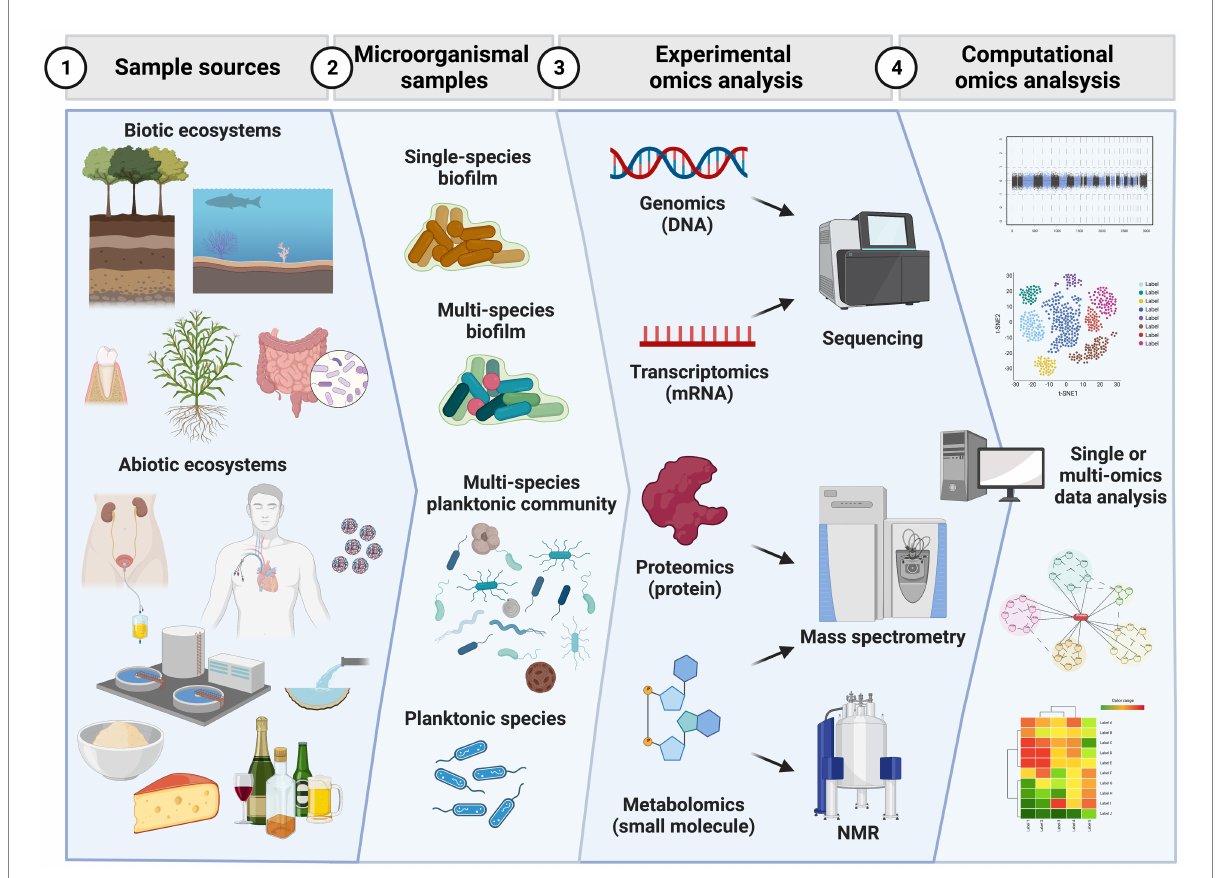
FIGURE 1 Workflow of major steps in omics analysis of microorganismal samples. Initial specimens can be obtained from biotic (e.g., plants, animals) or abiotic (e.g., medical devices, food, pipes, water) ecosystems. In these sources microorganismal samples can be present as planktonic and biofilm growing communities of a single or multiple species. From the microorganismal samples single or multiple omics experiments can be conducted by extracting singly or simultaneously genomic DNA, messenger RNA, proteins or chemical small molecules (metabolites). Genomics and transcriptomics experiments have third generation sequencers as end point analytical instruments to produce data while proteomics and metabolomics use mass spectrometry as end technology. Metabolomics also takes advantage of nuclear magnetic resonance (NMR) measurements. The huge amount of data can then be analyzed in a separate or integrative approach. Data analysis approaches based on statistics, complexity reduction, classification and prediction via machine learning tools are used to interpret the rich amount of data obtained and answer and generate new hypotheses. Created with